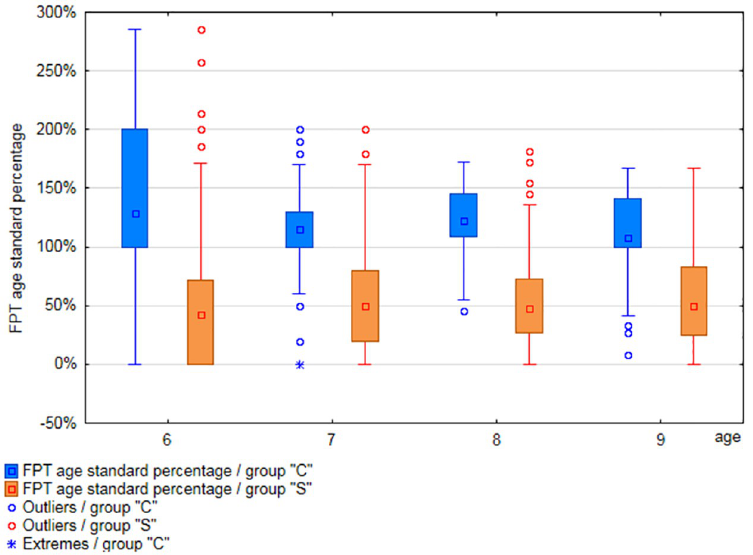
Fig 10. Results of the FPT test (age standard percentage), in 6-, 7-, 8-, and 9-year-olds, in groups”S” and”C”.